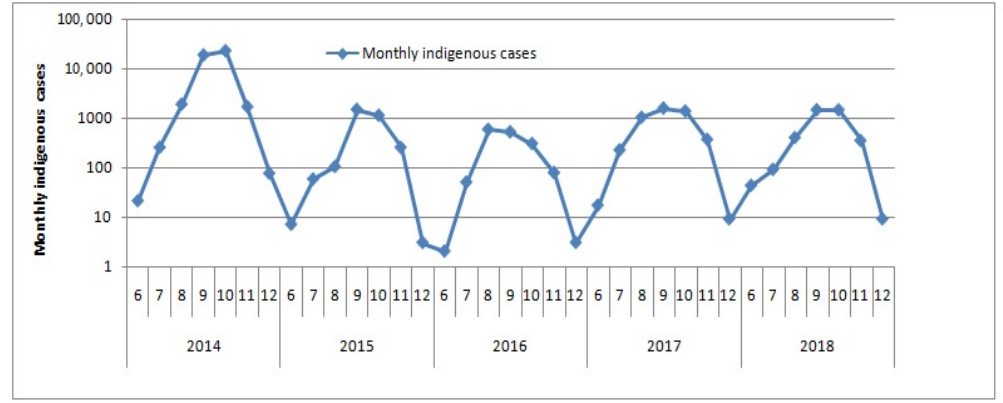
Figure 4. Time-series mapping of monthly indigenous dengue cases.